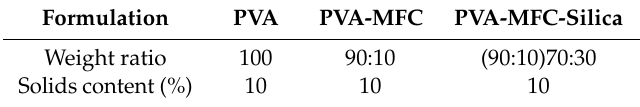
Table 1. Coating formulations.